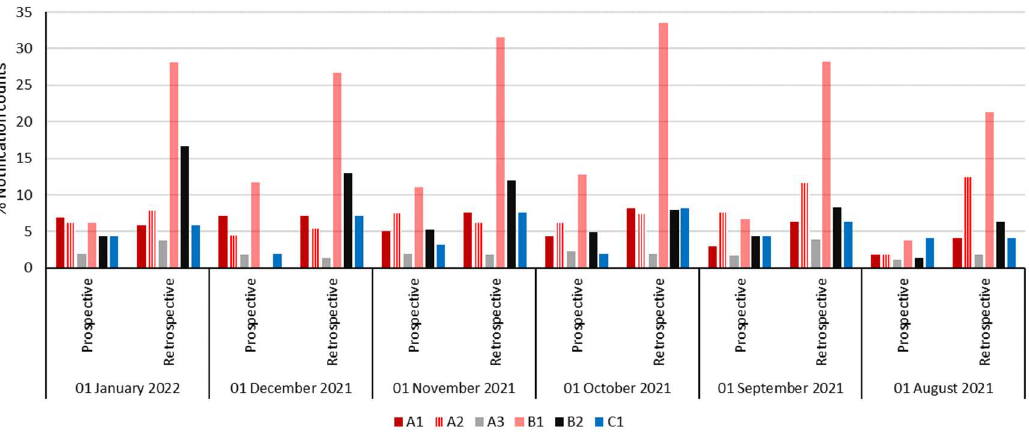
Figure 3. Demonstrates the percentage of notification counts using both tools prospective, i.e., CT console view tool and retrospective, i.e., DOSE TQM view tool for patients undergone CT studies across the 6 CT scanners during the 6-month period.